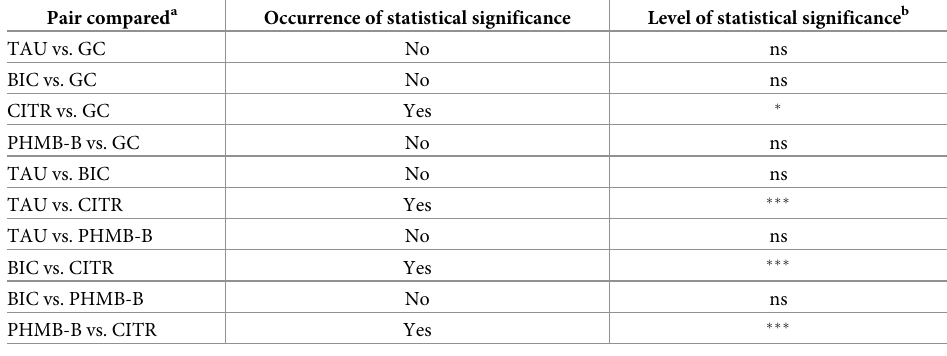
Table 1. Comparison of the compounds’ efficacy against biofilm formed on the catheter surface. Pair compared a Occurrence of statistical